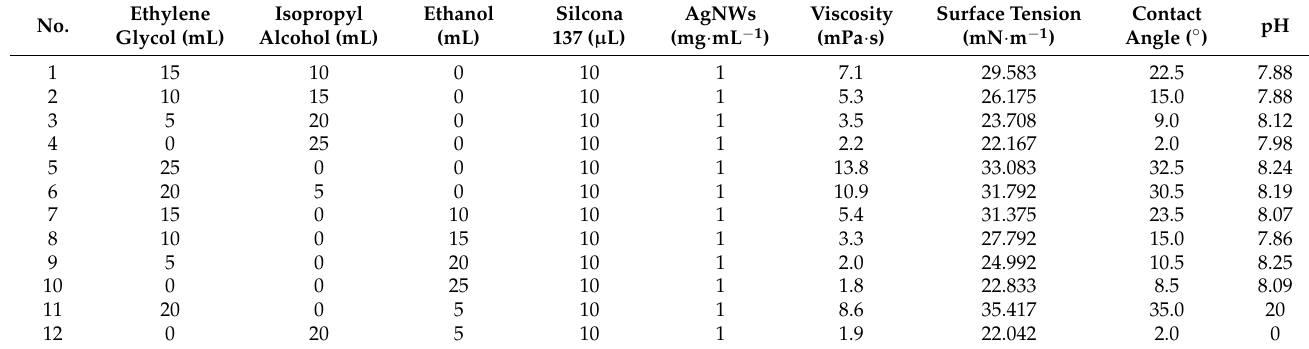
measurements for the various solutions are given in the Table 1. The viscosity of the mixed solution and the CA between the ink droplet and the PET surface decreased after adding 10 µ m of Silcona 137, which had little effect on the surface tension and the pH value. Table 1. Viscosity and surface tension and CA and pH value of the AgNWs inks with different formulations (at 28 ◦ C). Ethylene Isopropyl No. Glycol (mL) Alcohol